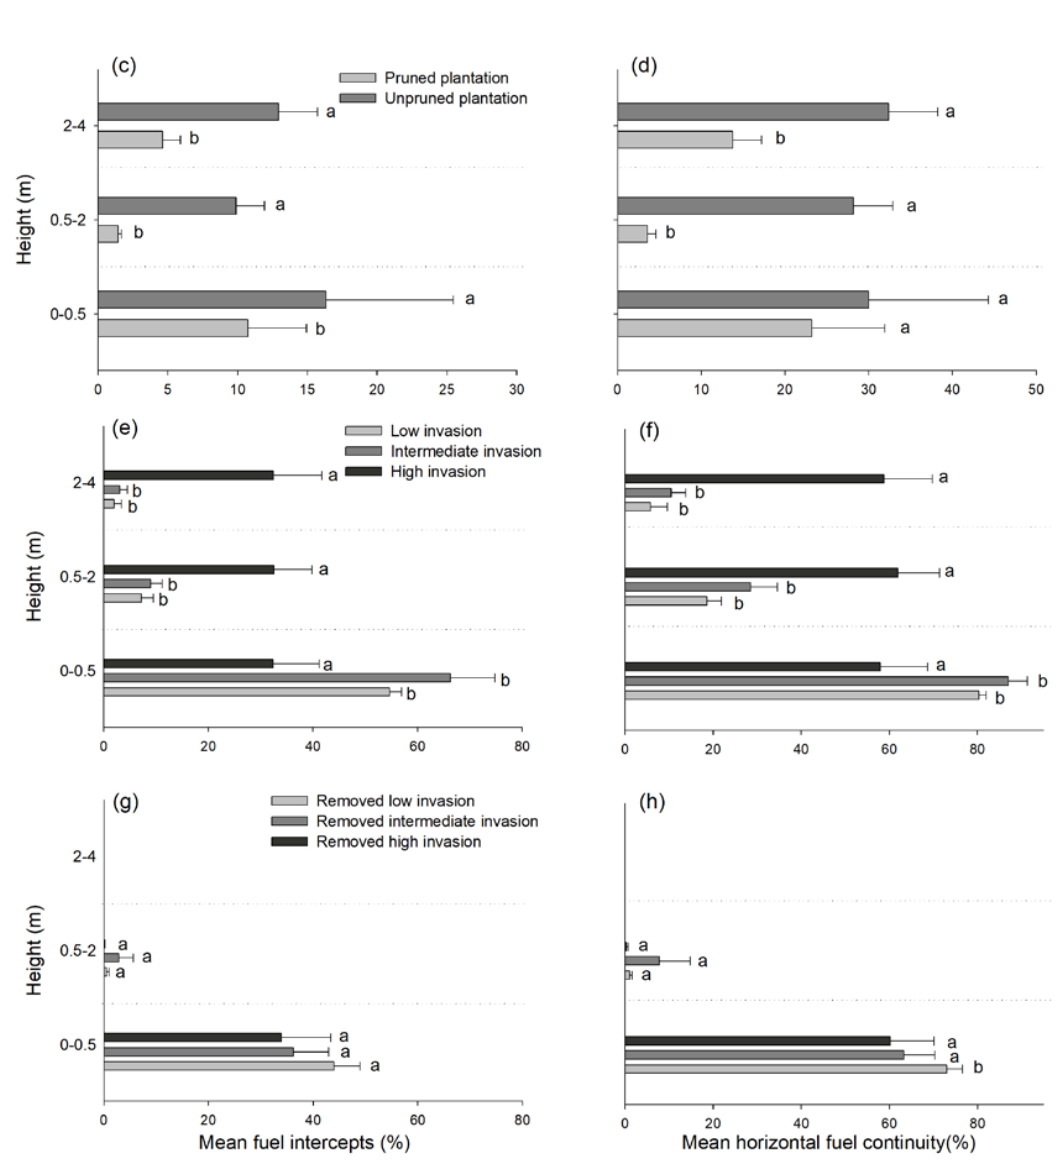
Figure 3. Vertical distribution of the mean fuel intercepts and mean horizontal continuity (±SE) of each treatment grouped into three height classes. Bars represent mean total (live plus dead) fine fuel intercepts. We evaluated the differences in fuel structure among steppe, invasion, removed invasion, and plantation treatments ( a , b ); between pruned and unpruned plantations ( c , d ); among the three levels of invasion ( e , f ); and among the three levels of removed invasion ( g , h ). Different letters indicate significant statistical differences ( p < 0.05) among treatments within each height class based on the generalized linear mixed-effects models.